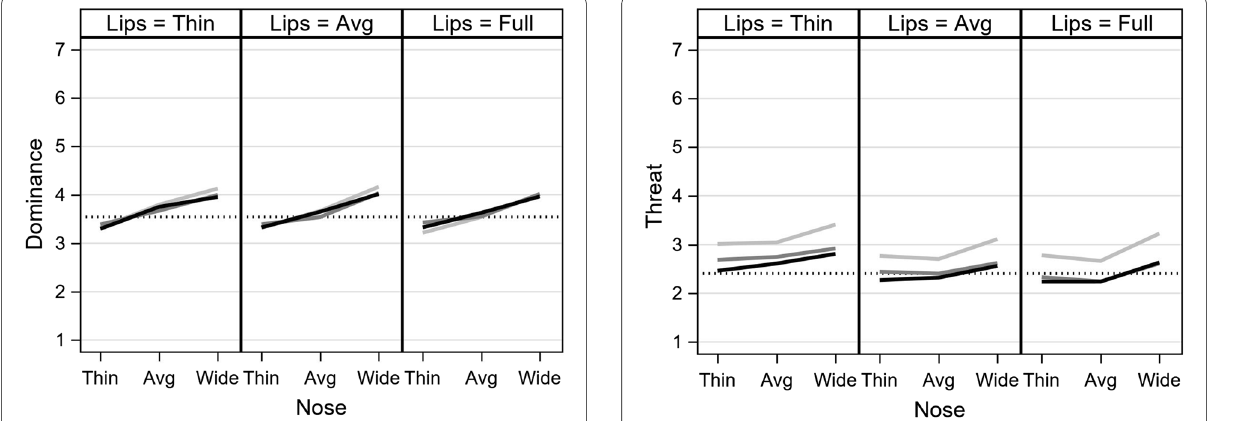
Fig. 3 Model‑predicted threat ratings. The vertical axis is the predicted threat score, with a black, dotted line for the model‑implied mean. The horizontal axis represents the levels of nose width. The three lines represent degrees of reflectance (none, medium, high). Each panel represents the degree of lip